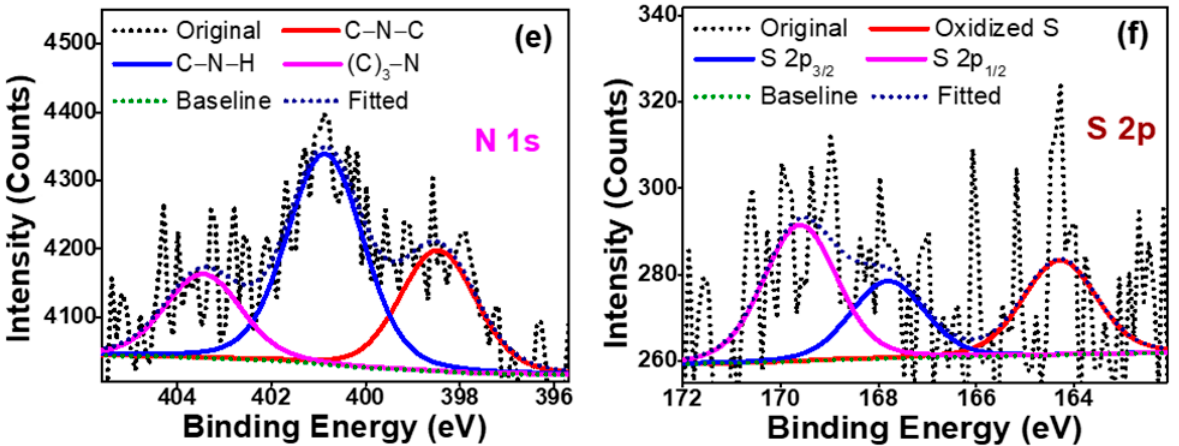
Figure 5. ( a ) ATR-FTIR and ( b ) XPS spectrum of the prepared ATC (inset: elemental composition chat of ATC). High-resolution XPS spectra ( c ) C 1 s, ( d ) O 1 s, ( e ) N 1 s, and ( f ) S 2p of ATC. The cyclic voltammetry (CV) curves at di ff erent scan rates (5 − 100 mV s − 1 ) and gal- vanostatic charge-discharge (GCD) curves at di ff erent current densities (0.5 − 3.0 A g − 1 ) of ATC in a three-electrode system are shown in Figure 6a,b, respectively. The CV curves exhibit stable quasi-rectangular shapes at lower scan rates, representing the ideal EDLC capacitive behavior and good reversibility for the electrolyte ions diffusing rapidly to the electrode interface [44,45]. Besides, the morphology of the CV curve departs to some ex- tent from its quasi-rectangular shapes with increasing scan rates, and the area of the cyclic voltammogram increased with increasing the scan rates, demonstrating the existence of